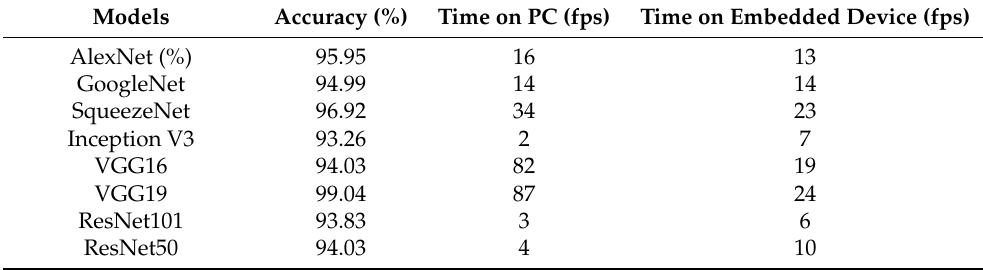
Table 2. Validation accuracy after fine-tuning the proposed insect classifier. Models Accuracy (%) Time on PC